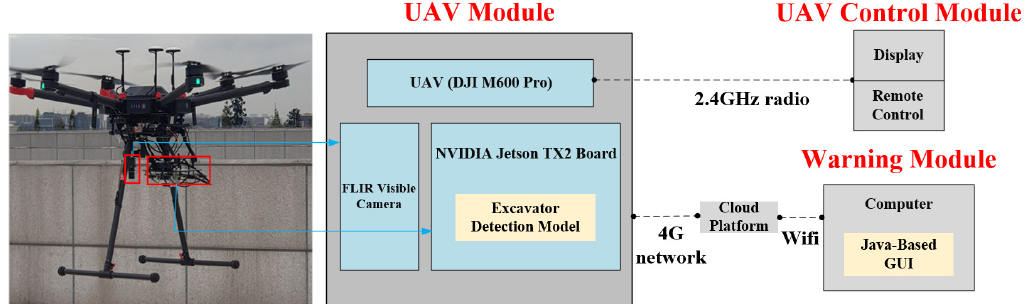
Figure 5. Architecture of the developed UAV-ED system. The UAV-ED system is composed of three modules, including the UAV Module, the UAV Control Module, and the Warning Module. The UAV Module integrated the excavator detection model, the sensor and the UAV. The UAV Control Module and the Warning Module are used to realize the real-time transmission of the detected excavators’ information.